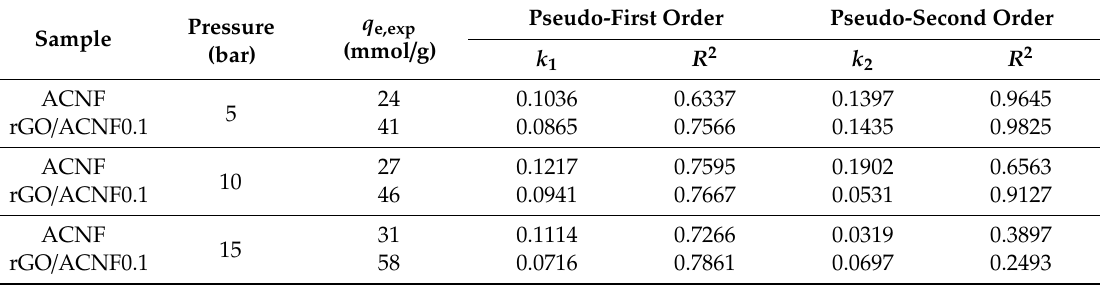
Table 4. The fitted parameters of pseudo-first order and pseudo-second order of ACNF and rGO / ACNF0.1 composite.